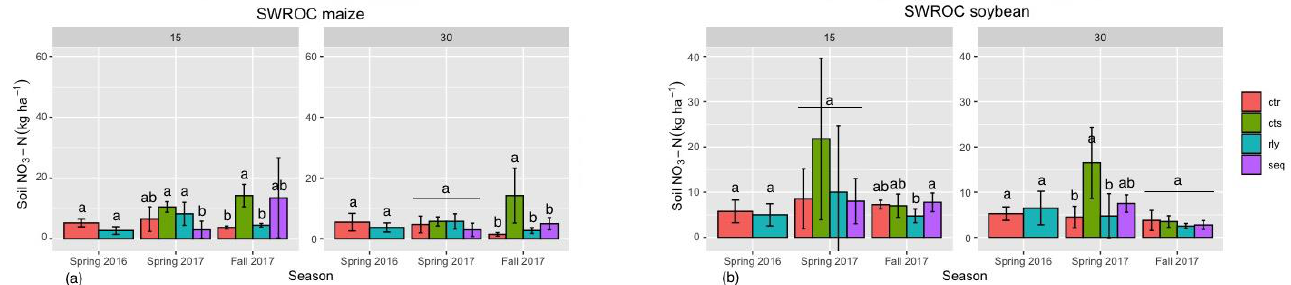
Figure 1. Effects of non-N-fertilized winter camelina double cropped with maize and soybean on soil available N in two soil layers: ( a ) 0 − 15 cm and ( b ) 15 − 30 cm. Vertical lines denote standard deviation. Southwest Research and Outreach Center (SWROC), 2016–2017. ctr = control relay, cts = control sequential, rly = relay cropping, and seq = sequential cropping. In a given season and depth within a location, bars followed by different letters are significantly different at p ≤ 0.05.